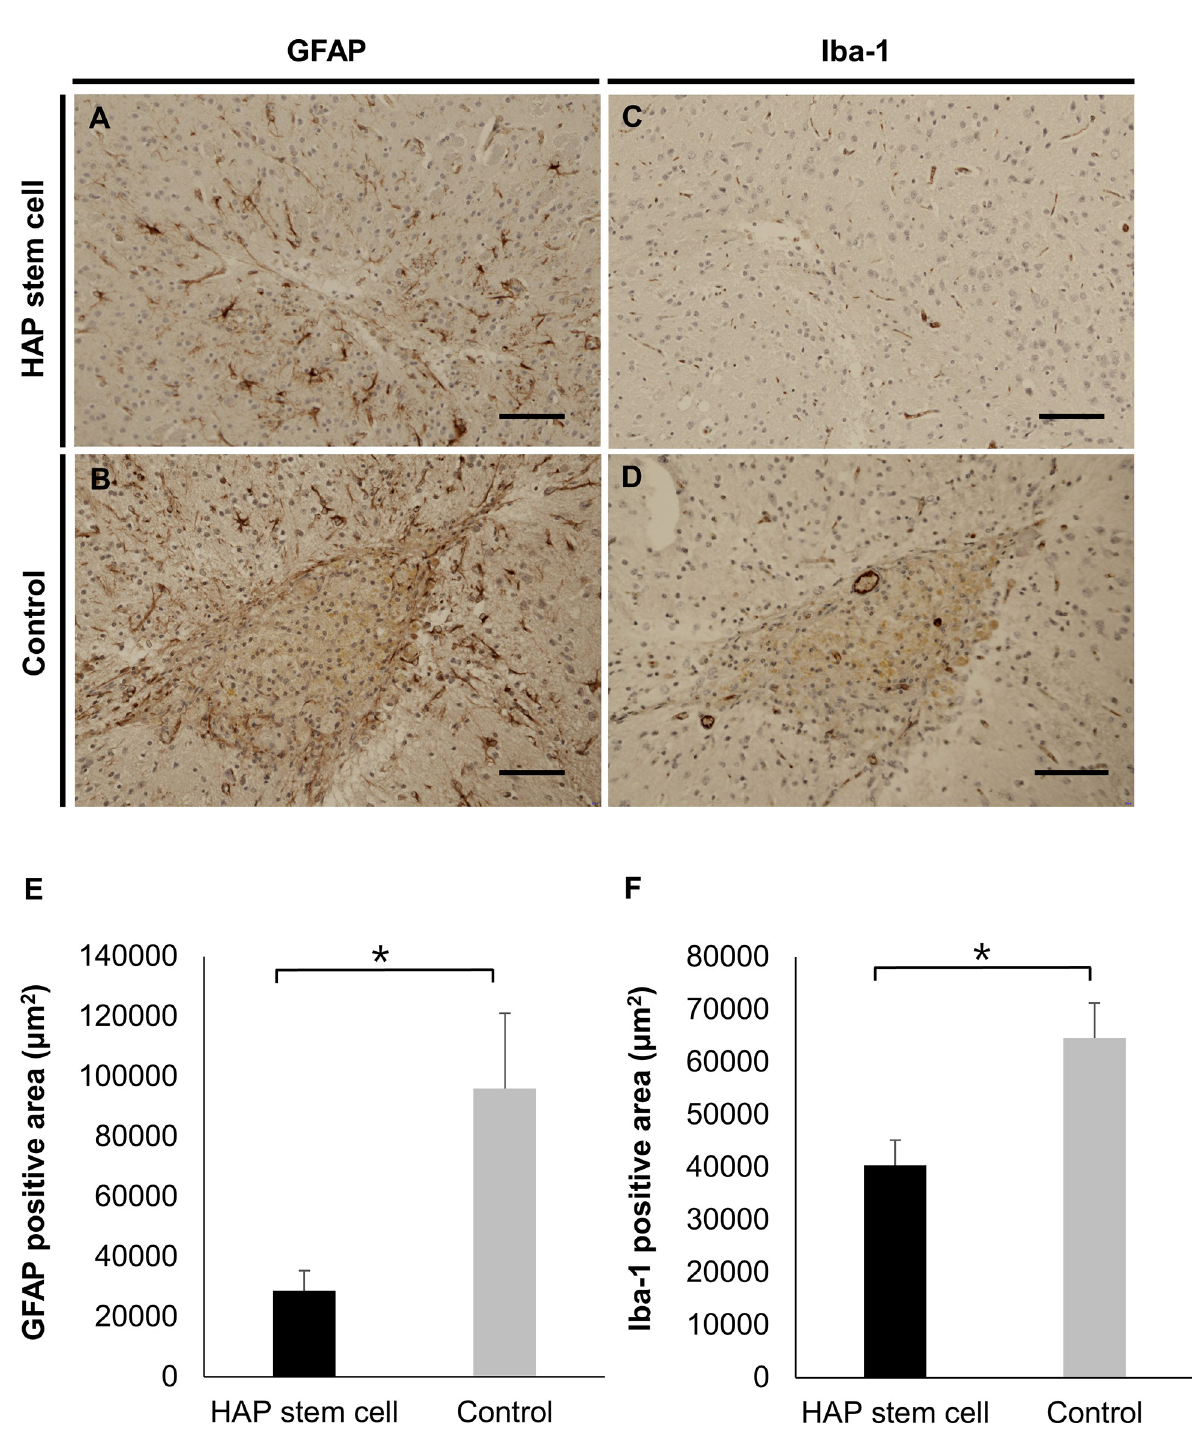
Fig 3. Implanted HAP stem cells inhibit glial scar formation at the ICH site in C57BL/6J. (A, B) Expression of GFAP of astrocytes in the ICH area with and without HAP-stem-cell-implantation in C57BL/6J mice. Glial scar formation was observed in the non-implanted control mice but not HAP-stem-cell-implanted mice. (C, D) Expression of Iba-1 of microglia in the ICH area with and without HAP-stem-cell implantation in C57BL/6J mice. (E) The GFAP-positive area in coronal section of the brain in C57BL/6J mice was smaller in the HAP-stem-cell-implanted mice than in the non-implanted control mice (n = 4, each group). � P < 0.05. (F) The Iba-1-positive area in coronal sections of the brain in C57BL/6J mice was smaller in the HAP-stem-cell-implanted mice than in the non-implanted control mice (n = 4, each group). � P < 0.05. Bar = 50 μ m. All images show coronal sections of the